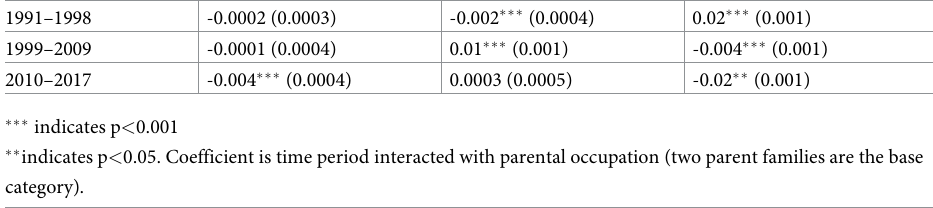
Table 5. Trends in the intergenerational correlation in SAH, GHQ and log of hourly wage by single parent house- hold over the period 1991–2017. Time period